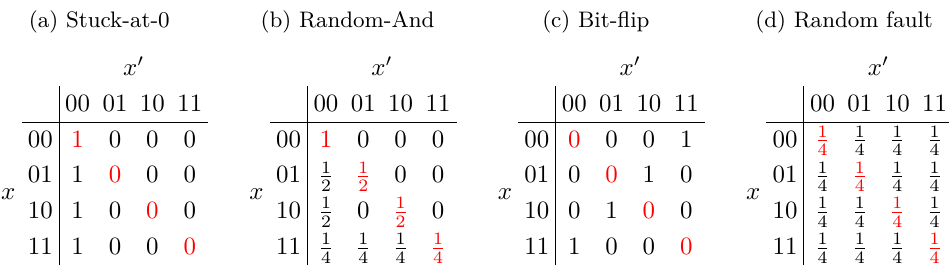
Table 1: Fault distribution tables for several 2-bit fault models.